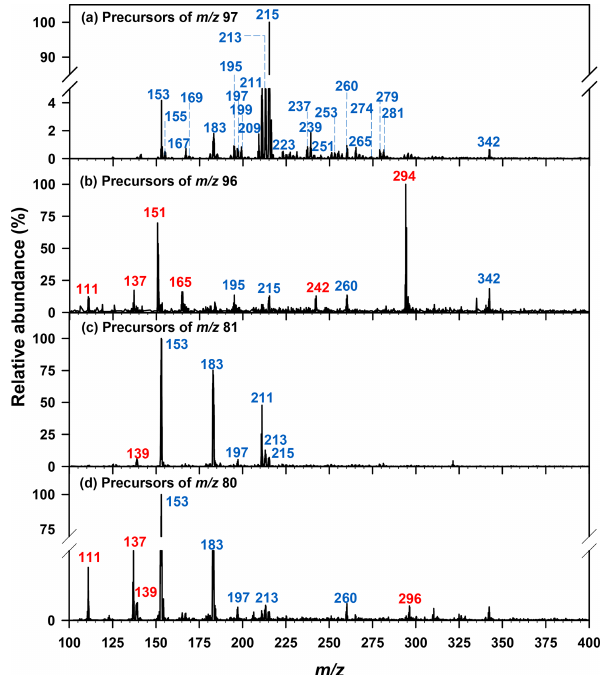
Figure 1. Precursors of (a) bisulfate ion ( m/z 97), (b) sulfate ion radical ( m/z 96), (c) bisulfite ion ( m/z 81), and (d) sulfite ion rad- ical ( m/z 80) identified from a sample collected on 30 July 2015 in Atlanta. Blue indicates nominal m/z of the major organosulfate species that were identified from the precursor m/z 97 scan. Red indicates nominal m/z of the major organosulfate species that were identified from the precursor m/z 96, 81, and 80